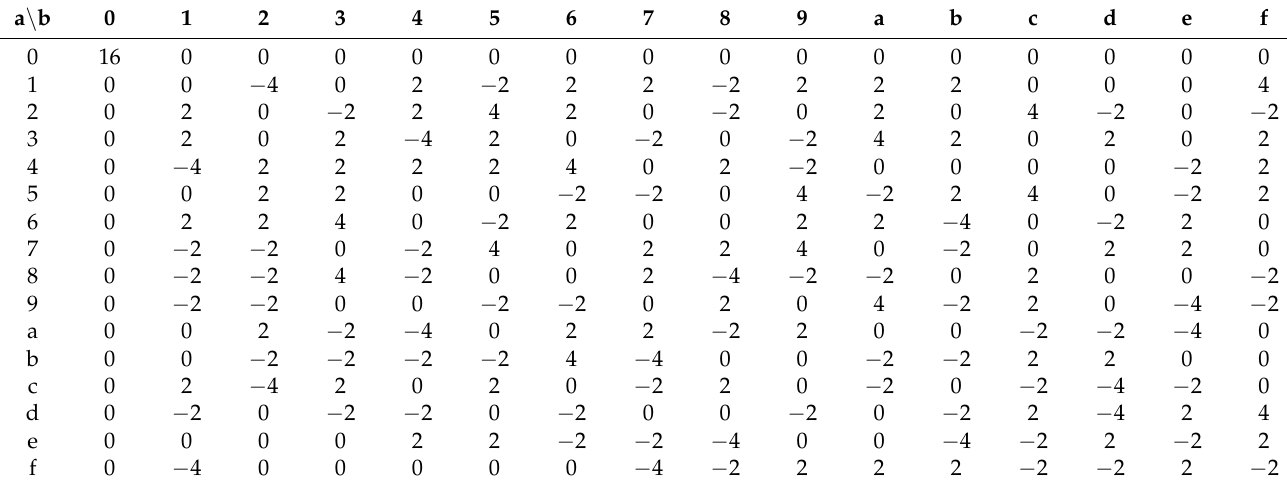
Table A4. Linear relations of